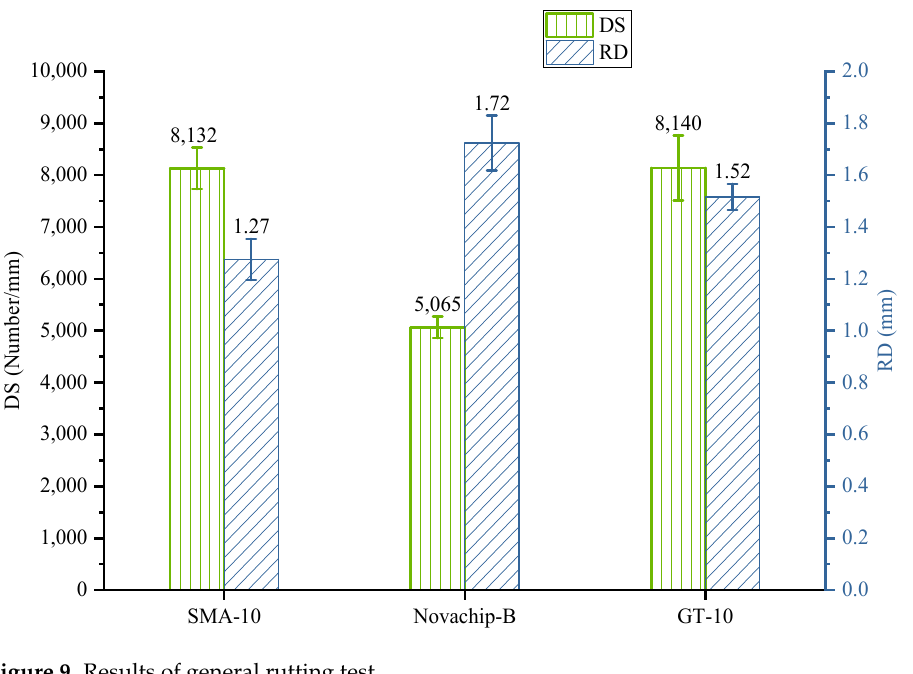
Figure 9. Results of general rutting test.